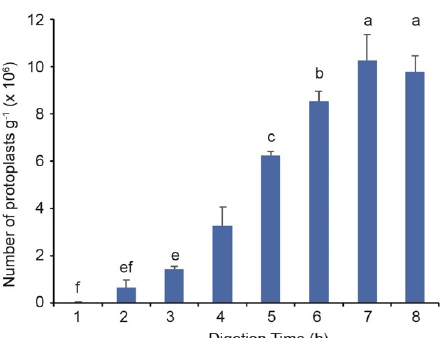
Figure 3. Yields of the protoplasts from banana suckers with different digestion times in enzyme solution ES9. The yields of protoplasts isolated from banana suckers with different digestion times, 1 to 8 h, in enzyme solution ES9. Y-axes represent the number of protoplasts per gram fresh weight ± SD ( n = 4). The different letters indicate statistically significant differences ( p < 0.05).